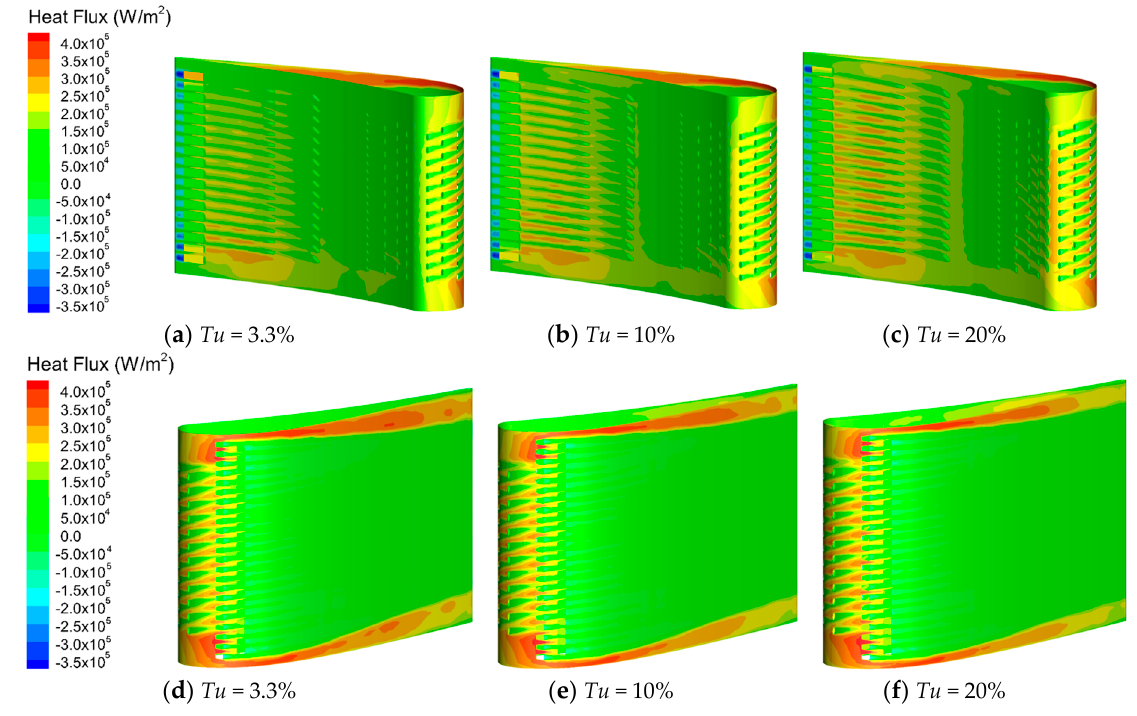
Figure 10. Heat flux on the uncoated vane ( a – c ) on the PS; ( d – f ) on the SS at three Tus .